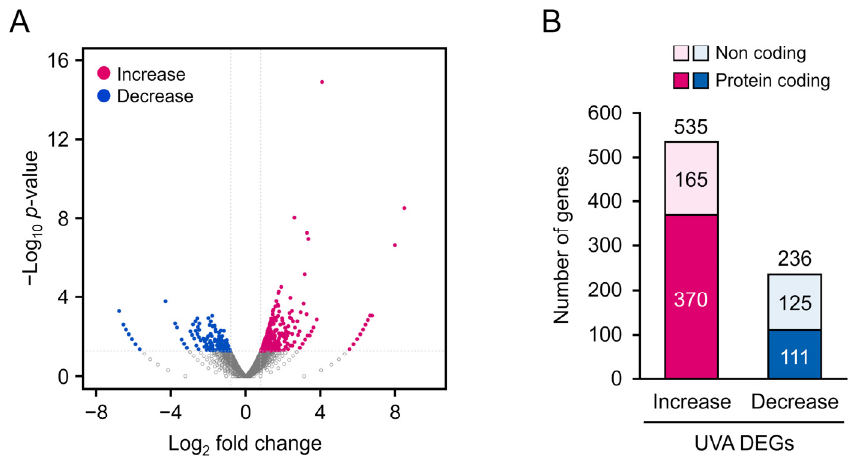
Figure 3. ( A ) Volcano map of 771 differentially expressed genes (DEGs) ( p < 0.05, log 2 fold-change > 0.8). Significantly upregulated and downregulated DEGs are represented as blue and red dots, respectively. ( B ) Distribution of DEGs.